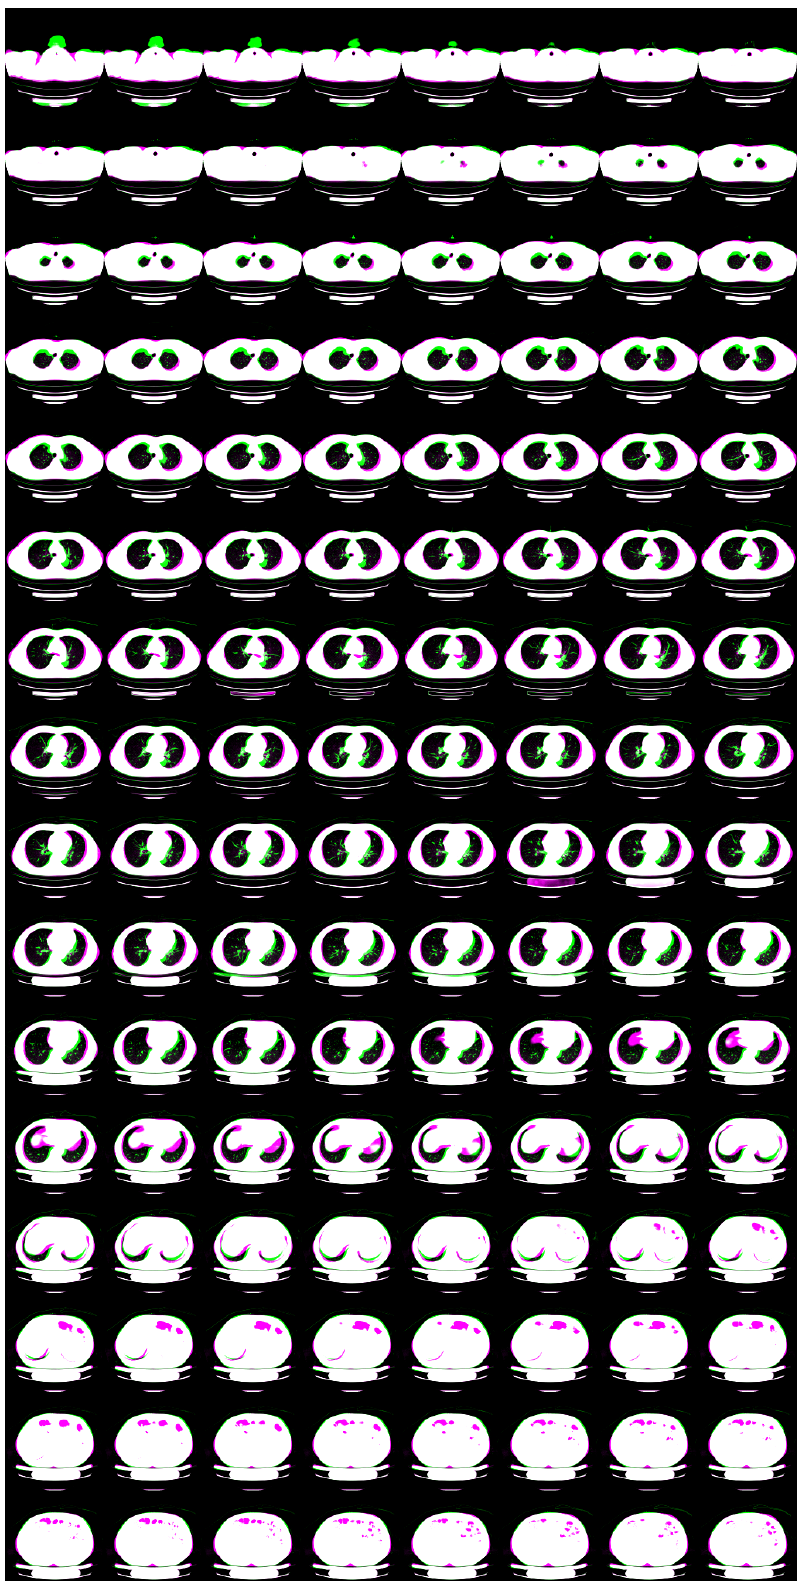
Figure 9. Superposition of the reconstructed 3D CT image shown in Figure 8 (magenta) and the ground-truth image